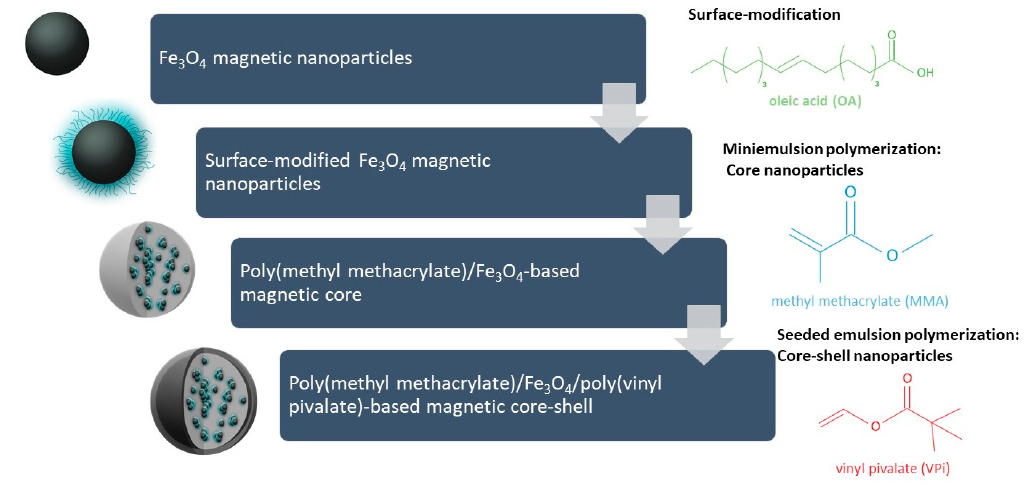
Scheme 1. Flowchart summarizing the experimental protocol for formation of poly(methyl methacrylate)/Fe 3 O 4 /poly(vinyl pivalate) magnetic core–shell